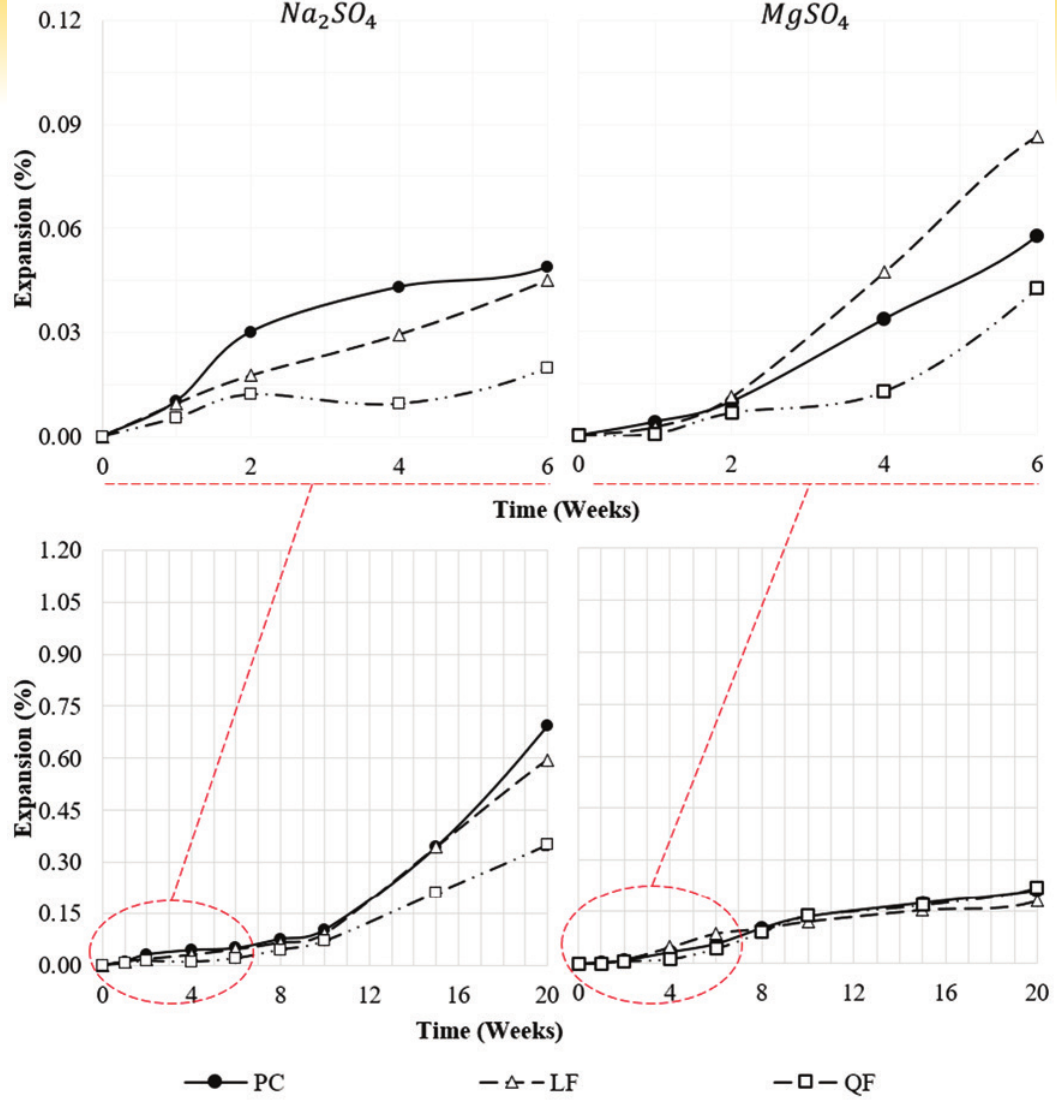
SO and MgSO (0.7 mol/L) 2 4 4